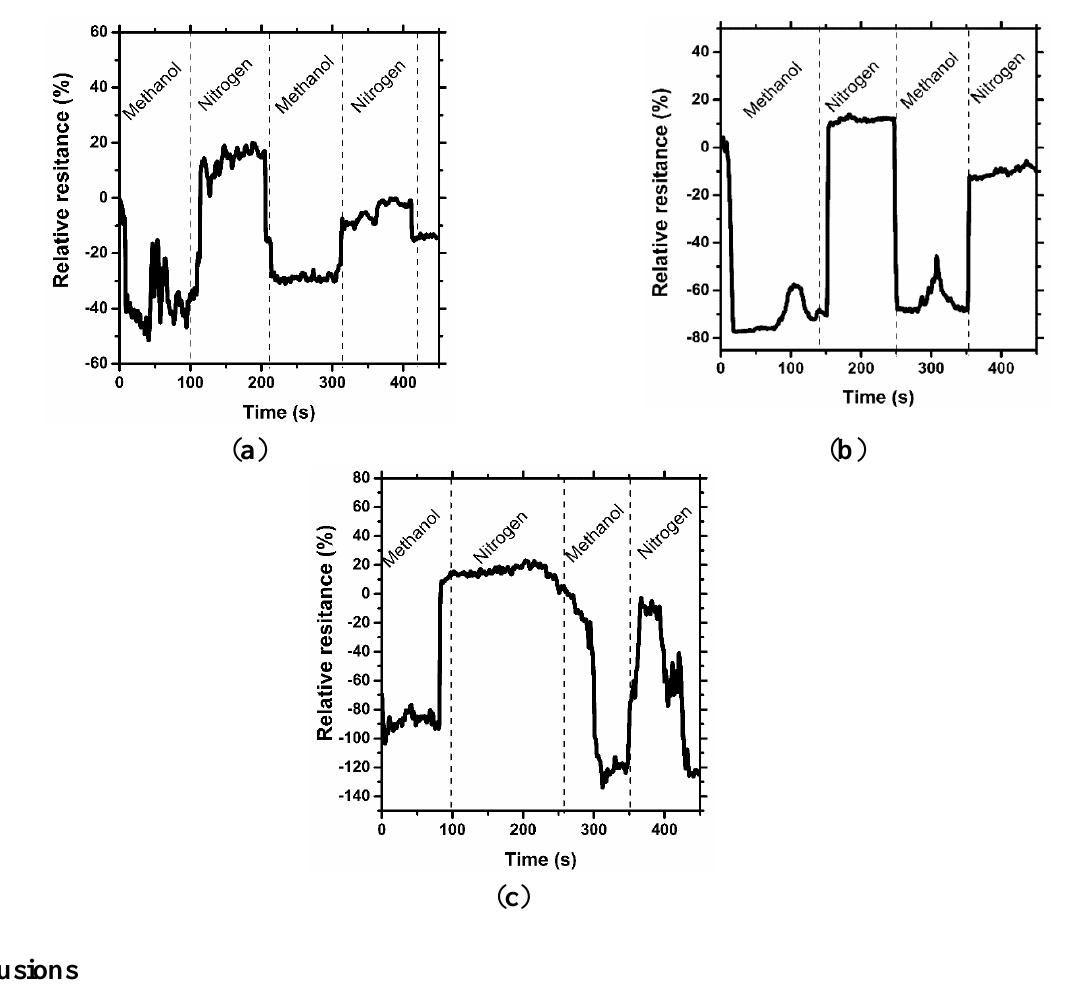
Figure 5. Characteristic sensing properties at 400 ppm methanol vapor for ( a ) AquaCyl AQ0301 + cross-linking compound, ( b ) AquaCyl AQ0301 + 1% graphene + cross-linking compound and ( c ) AquaCyl AQ0301 + 3% graphene + cross-linking